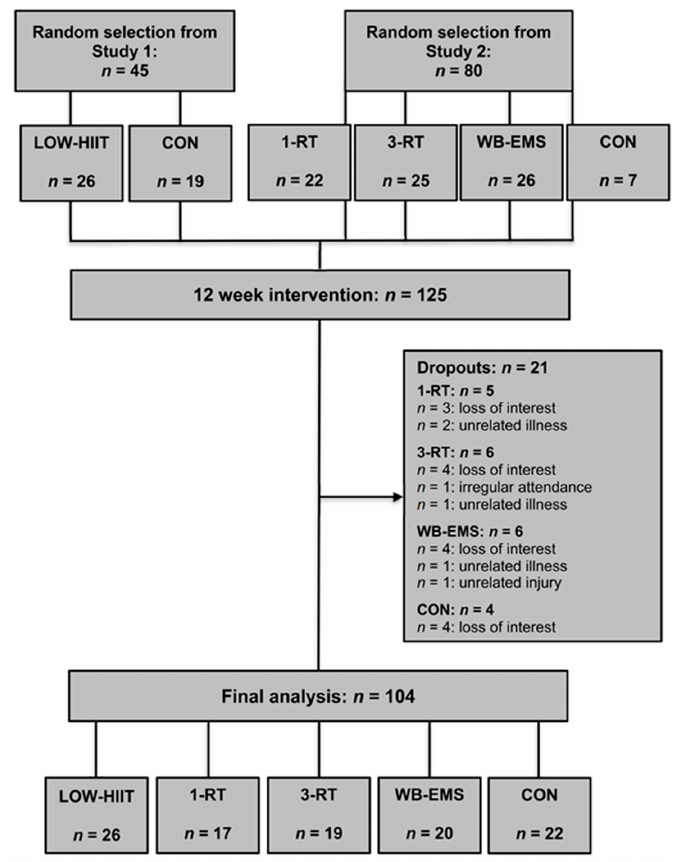
Figure 1. Study flow